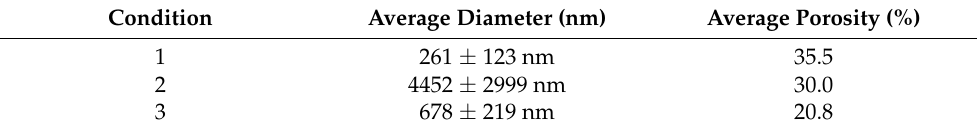
Table 2. Average diameter and porosity of the fibers obtained using different electrospinning con- ditions.